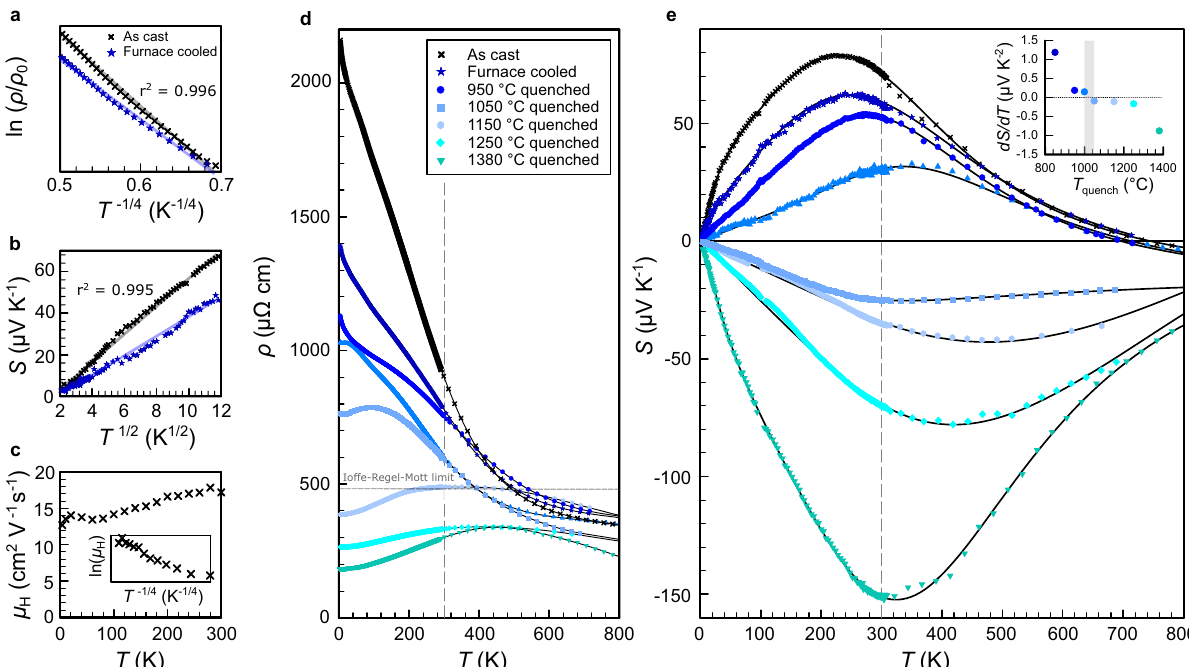
Fig. 4 Thermoelectric transport across the Anderson localisation − delocalisation transition. a – c Evidence from electrical resistivity, thermopower and Hall effect measurements for charge localisation and variable-range hopping behaviour in as-cast and furnace-cooled Fe 2 VAl at low temperatures. d Temperature-dependent resistivity of Fe 2 VAl with increasing quenching temperature. Dashed line denotes the Ioffe-Regel-Mott limit in Fe 2 VAl. e Sign reversal of the temperature-dependent thermopower with increasing quenching temperature. Inset shows the slope of S ( T ) at low temperatures for the different samples. Solid lines are guides to the